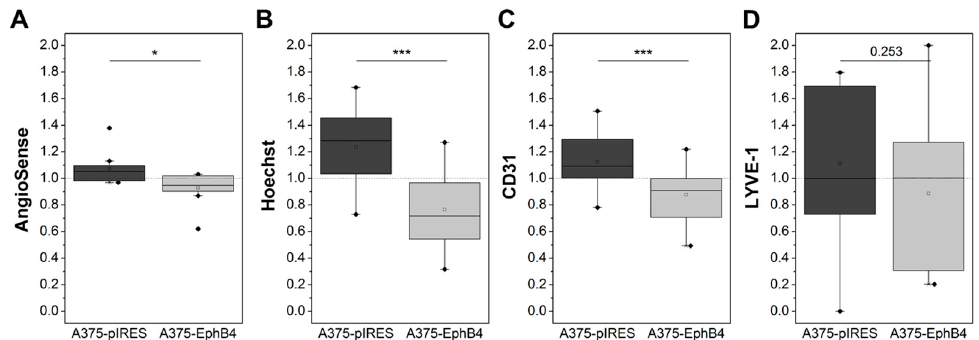
Figure 5. Overexpression of EphB4 in A375 melanoma cells decreases amount of functional blood vasculature in tumor xenografts as determined by in vivo fluorescence imaging, ex vivo Hoechst 33342 fluorescence microscopy, and CD31/ LYVE-1 immunohistochemistry. ( A ) In vivo fluorescence imaging of A375-pIRES/-EphB4 tumor-bearing NMRI nu/nu mice was performed 24 h post i.v. injection of AngioSense. Mean fluorescence intensity of AngioSense (750/790 nm) was divided by mean fluorescence intensity of reference channel (430/535 nm). ( B ) Mice were sacrificed exactly 1 min post i.v. injection of 30 mg/kg Hoechst 33342. Tumor cryosections were analyzed by fluorescence